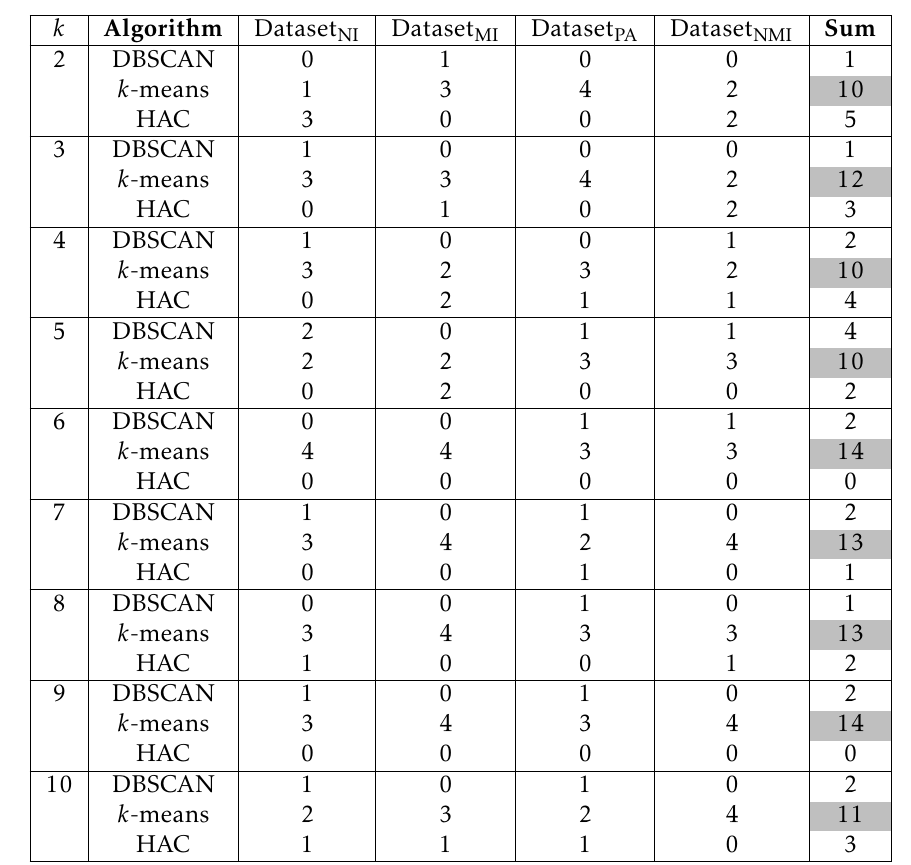
Table 2. Comparison of clustering performances.